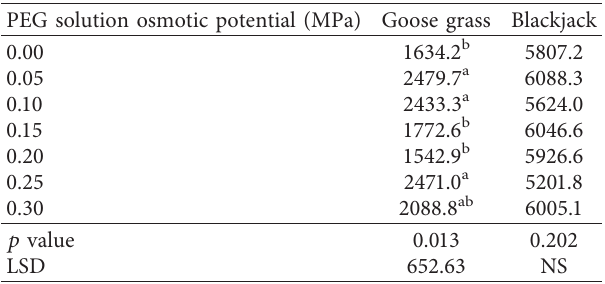
Means followed by different letters in the same column are significantly different at p < 0 . 05.